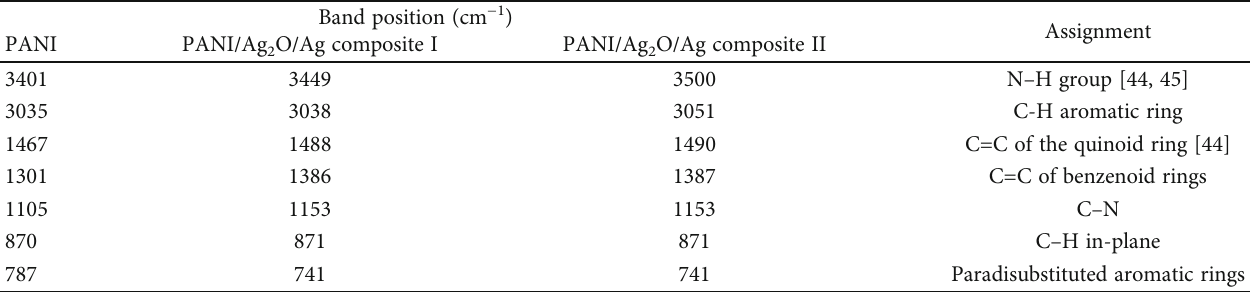
O-Ag composites I and II. 2